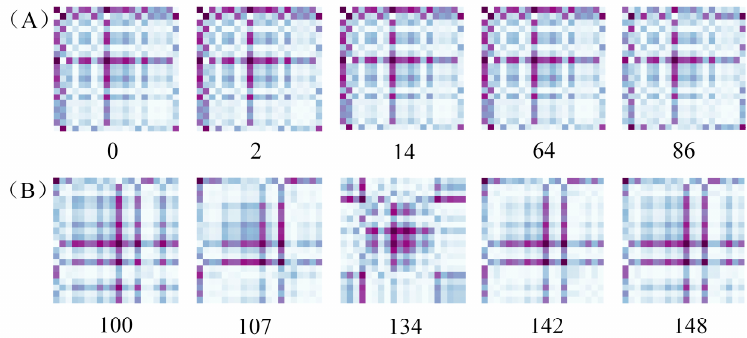
Figure 10. GAF graphs of spectra of some pear samples: ( A ) healthy pears; ( B ) browned pears.